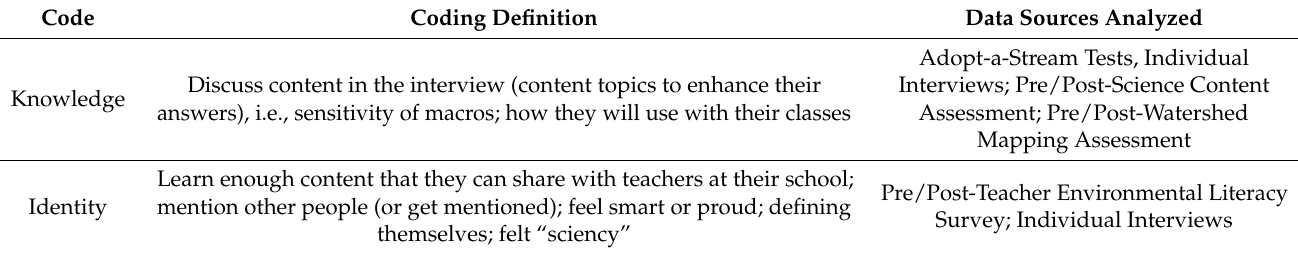
Table 3. Data coding